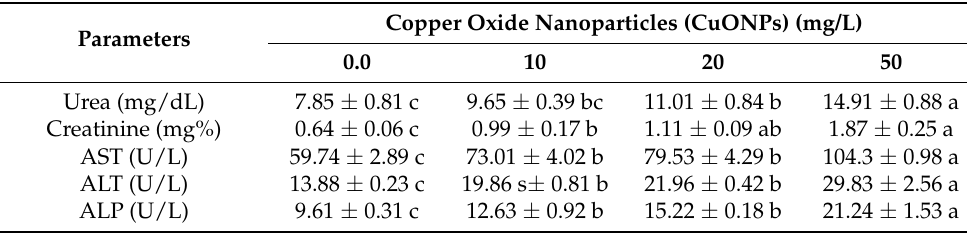
Table 2. Changes in serum biochemical indices in Nile tilapia juveniles following exposure to sub-lethal levels of CuONPs for a long exposure period (25